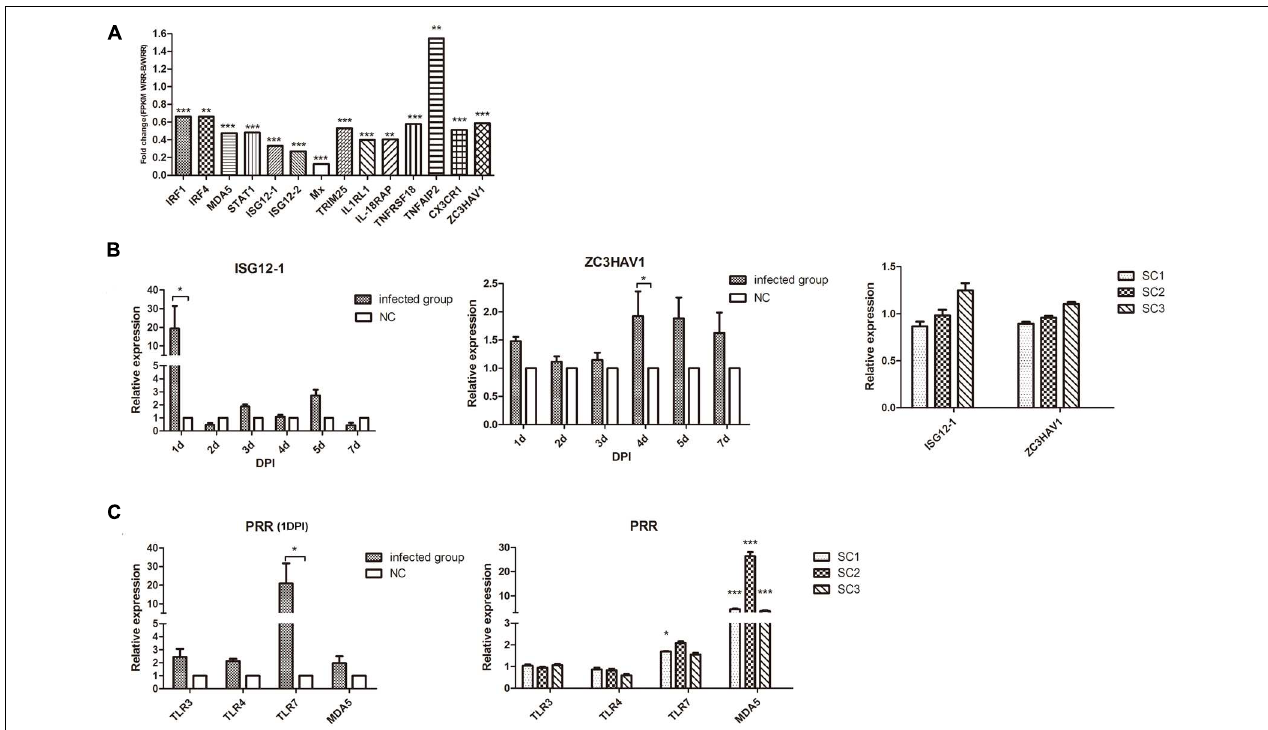
FIGURE 2 | Transcriptional analysis of IFN-stimulated and pattern recognition receptor (PRR) genes in chicks and chickens with tumors. (A) . transcriptome analysis of splenic genes related to innate immunity based on our previous study of ALV-J-induced tumors in White (Recessive) Plymouth Rock chickens (Li et al., 2015). (B) Quantitative analysis of the expression of ISG12-1 and ZC3HAV1 in chicks (Left) and chickens with tumors (Right). (C) Quantitative analysis of the expression of PRRs in chicks (Left) and chickens with tumors (Right). Expression is relative to the average of the NC group ( n = 3) for (B) Right and (C) Right. ∗ p < 0.05, ∗∗ p < 0.01, ∗∗∗ p <